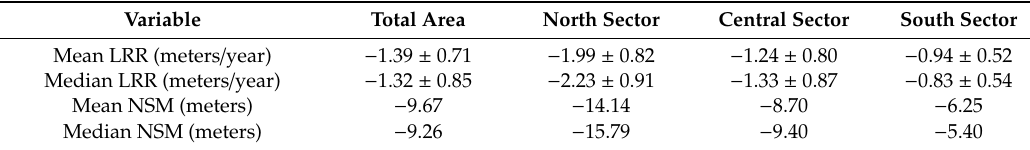
Table 6. Evolution rates between 2010 and